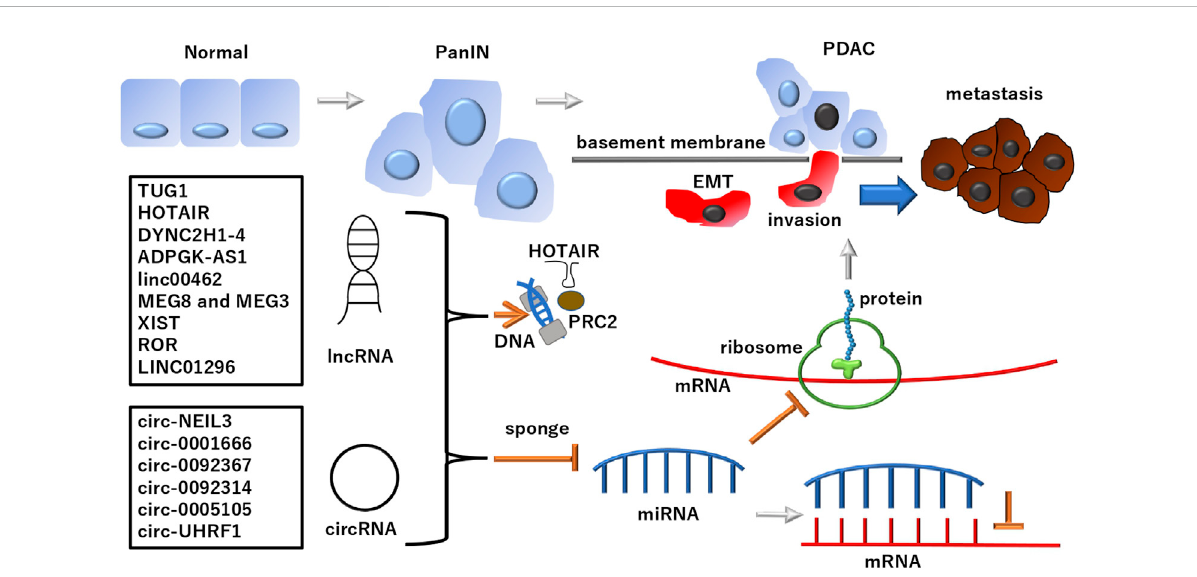
FIGURE 1 lncRNAs and subclass circRNAs in PDAC PDAC developed from normal ducts in the pancreas and its altered precancer lesion, pancreatic intraepithelial neoplasia (PanIN) (Suryavanshi et al., 2017; Ma et al., 2021). lncRNAs and subclass circRNAs can suppress the miRNA-dependent inhibition ofmRNA transcripts and their translated proteinproducts involvedinthedevelopment ofPDAC. Notably, lncRNAsand circRNAs playroles in EMT regulation, which is involved in PDAC metastasis: A phenomenon causing fatal outcomes in patients. Although lncRNAs and circRNAs deploy various mechanisms and functions, as mentioned in the text, the schematic of a typical pathway is depicted in this fi gure. The multi-faced function of ncRNAs includes the involvement in epigenetic regulation for PRC2 by HOTAIR. See each abbreviation in-text. lncRNA, long noncoding RNA; circRNA, circular RNA; PRC2, polycomb repressive complex 2; PDAC, pancreatic ductal